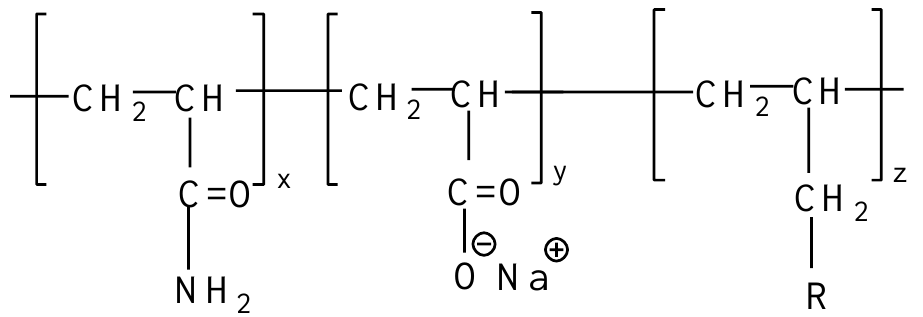
Figure 1. The molecular formula of AP-P4. (2) Experimental brine: 3000 mg/L sodium chloride was used to simulate the influence of cations in the aqueous solution on the polymer solution. (The higher the salinity, the greater the performance of the polymer solution. The determination of a specific concentration of salinity is the basis of the study. The selection of low salinity is conducive to the analysis of the impact of shear action on the polymer